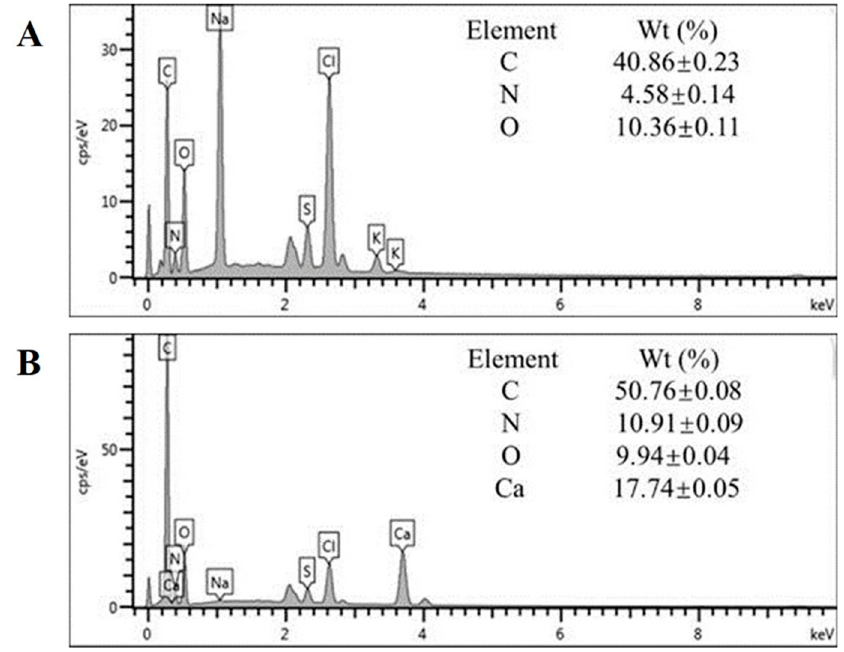
Figure 2 . The EDS pattern and percentage of EWP ( A ) and EWP–Ca ( B ) elements . Figure 2. The EDS pattern and percentage of EWP ( A ) and EWP-Ca ( B )